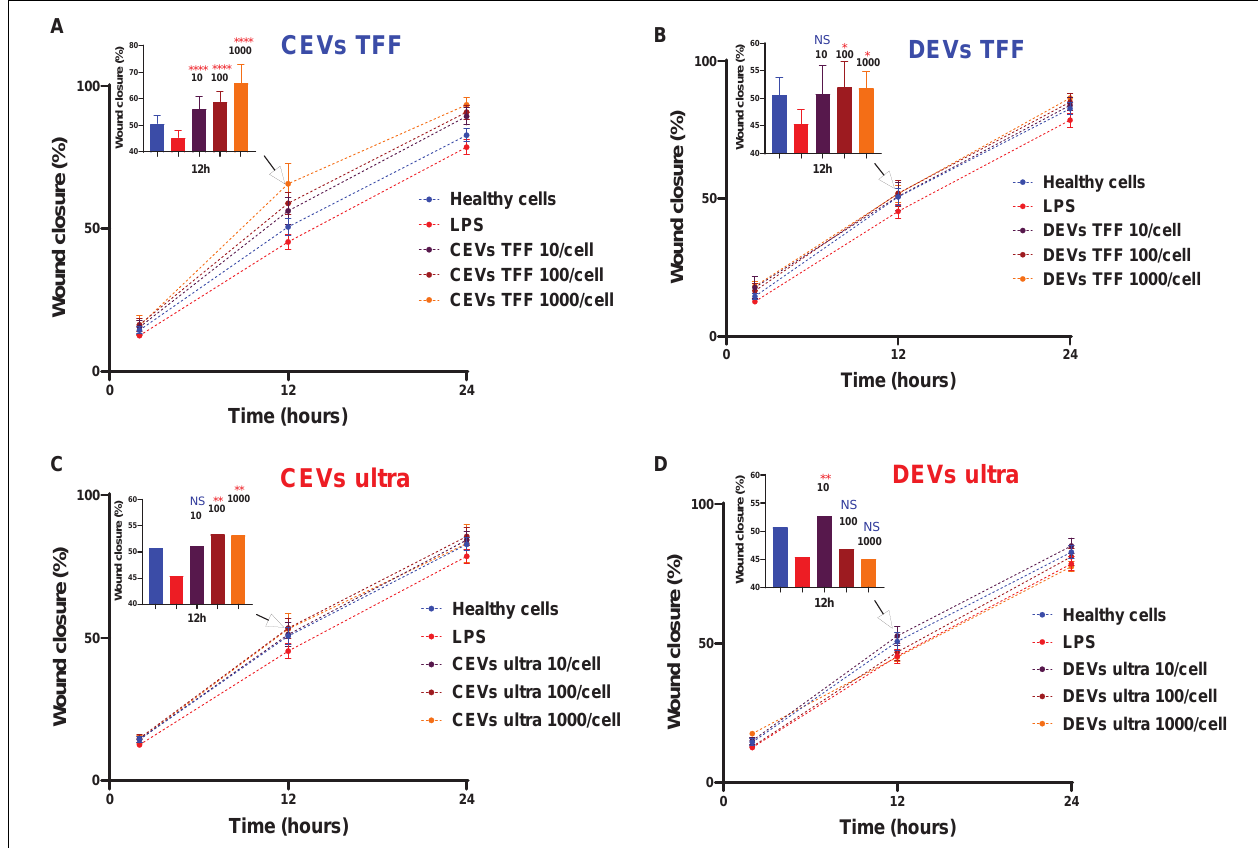
FIGURE 6 | Assessment of wound closure in injured BEAS-2B in response to EV treatment. BEAS-2B cells were “injured” with 10 µ g/ml of LPS and treated with CEVs isolated using (A) TFF and (C) ultracentrifugation; DEVs isolated using (B) TFF and (D) ultracentrifugation. Error bars represent standard deviation (SD), n = 8. Statistics significance was determined by ordinary one-way ANOVA test, followed by Dunn’s multiple comparisons test for pair-wise comparisons. Statistical significance shown was between LPS treatment and other groups at time point 12 h. ∗ P < 0.1; ∗∗ P < 0.01; ∗∗∗∗ P < 0.0001; NS, not